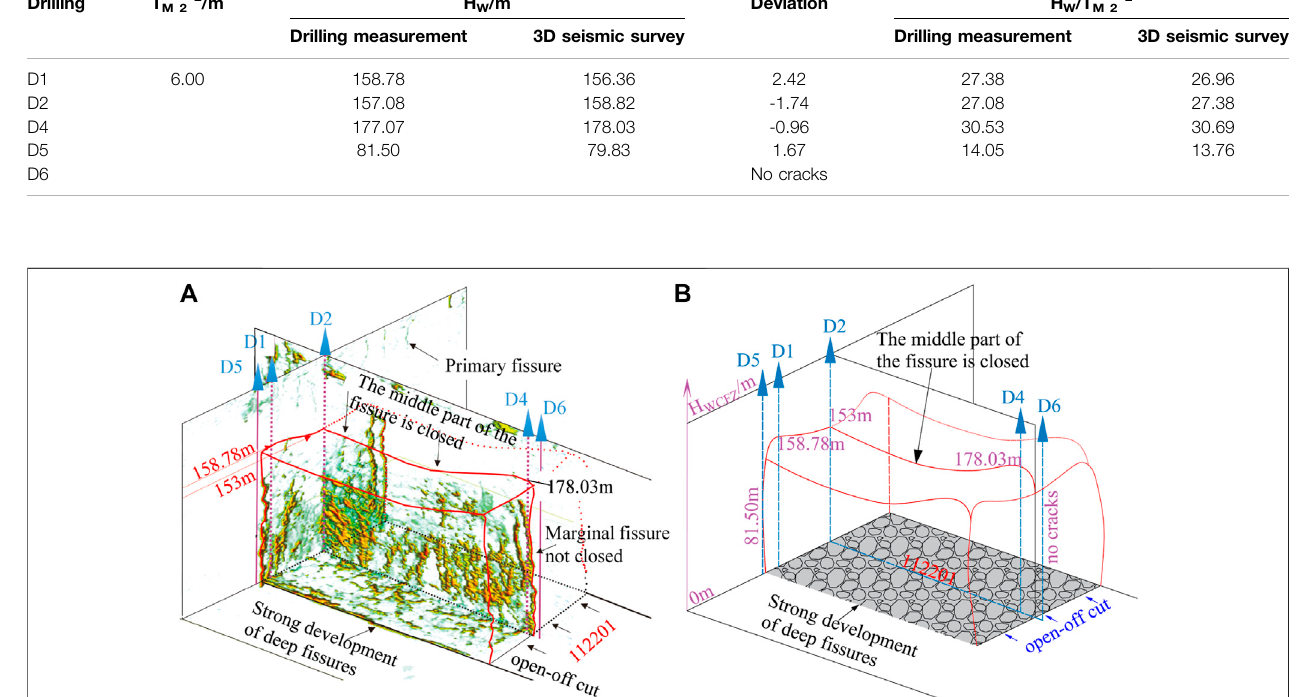
FIGURE 11 | Fracture indication inversion data hollow display. (A) 3D seismic survey interpretation results of the WCFZ. (B) Schematic 3D morphology of WCFZ.